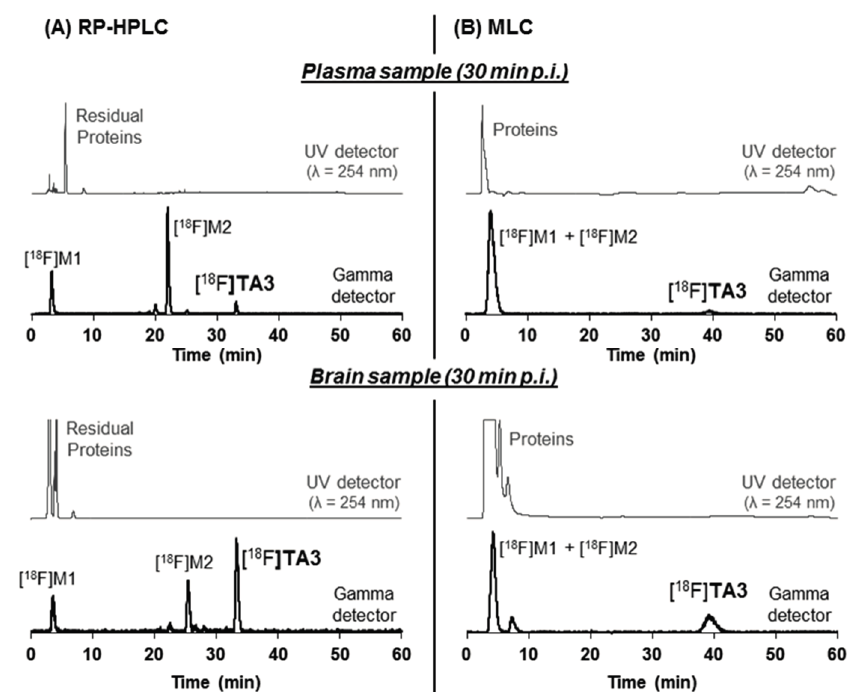
Figure 7. Representative in vivo metabolism study of mouse plasma and brain samples at 30 min p.i. of [ 18 F] TA3 (150 MBq): ( A ) RP-HPLC chromatograms of extracted samples (column: Reprosil-Pur C18-AQ, 250 × 4.6 mm, particle size: 5 µm; gradient: 10% → 90% → 10% MeCN/20 mM NH 4 OAc aq. ; flow: 1 mL/min); ( B ) MLC chromatograms of samples directly injected into the MLC system (column: Reprosil-Pur C18-AQ, 250 × 4.6 mm, particle size: 10 µm; gradient: 3% → 30% → 3% 1-PrOH/100 mM SDS aq. , 10 mM Na 2 HPO 4aq. ; flow: 1